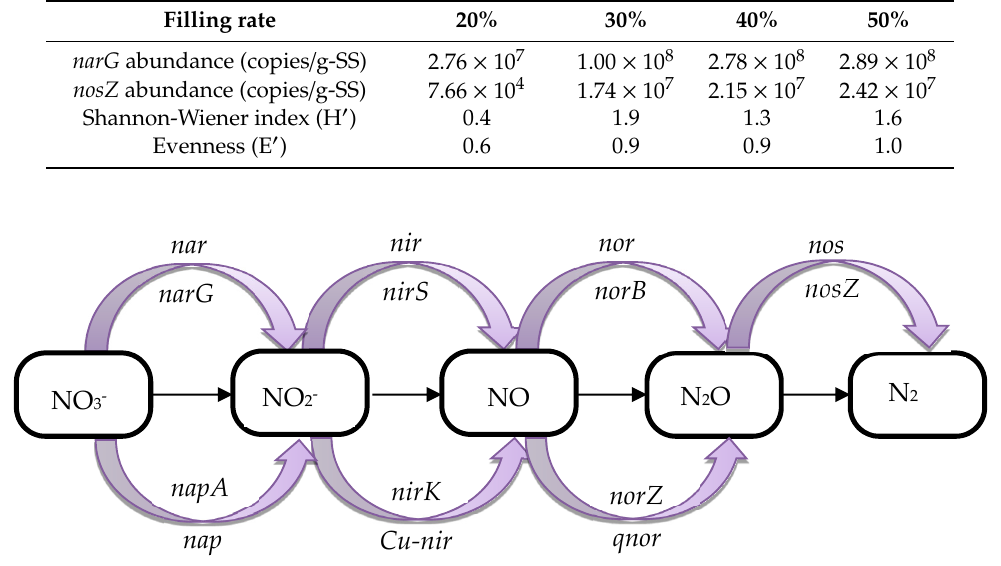
Figure 4. nosZ community structure at different FRs.